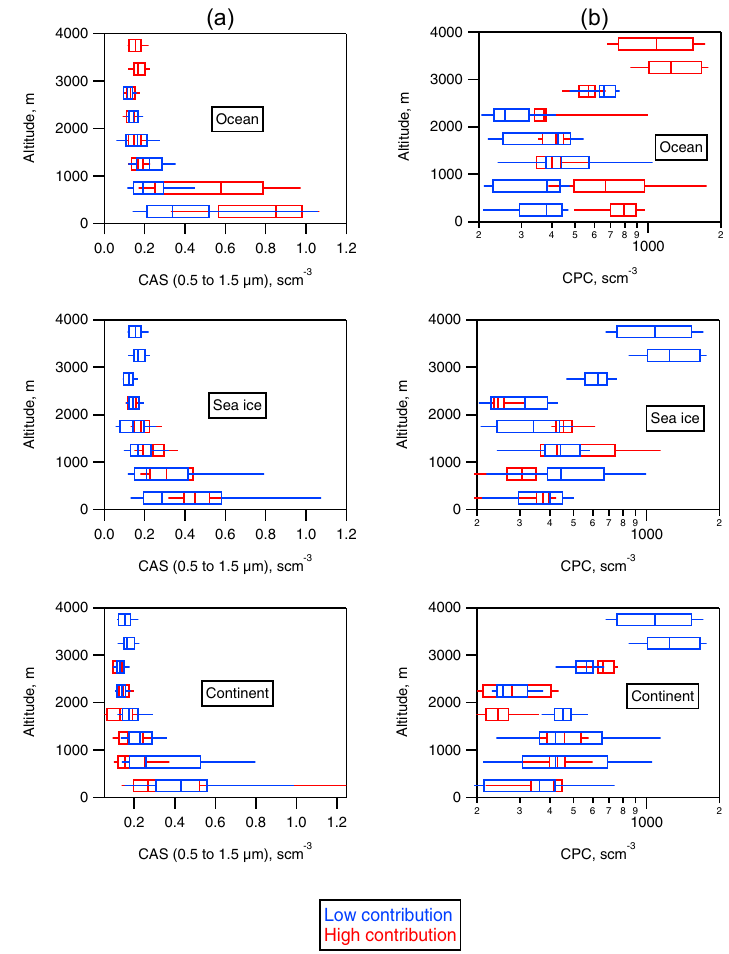
Figure 12. Altitude profiles of CAS aerosol over the size range 0.5 to 1.5µm (a) and total aerosol greater than 10nm from the CPC (b) . The measurements have been partitioned into periods when the air mass had high (red) and low (blue) contributions from different the Southern ocean (top panels), sea ice (middle panels) and the Antarctic continent (bottom panels; see text for